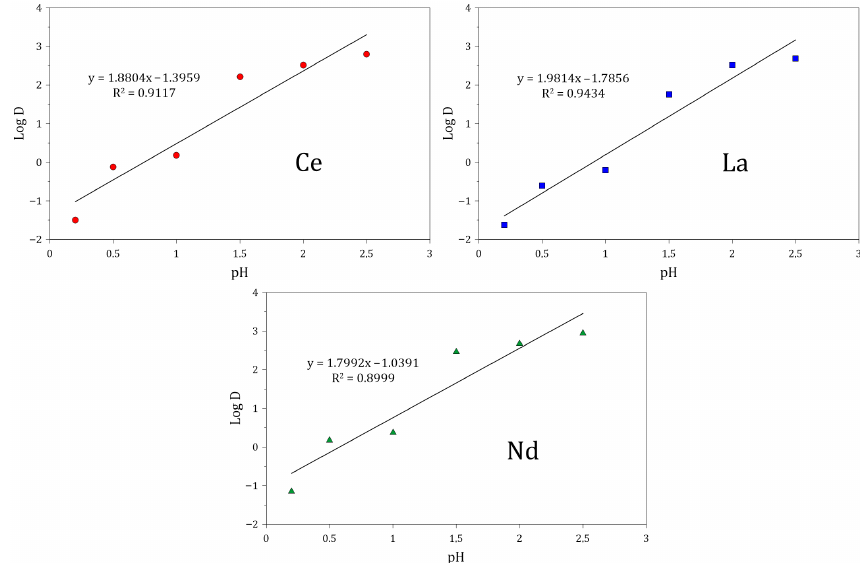
Figure 16. Log D vs. pH for the extraction of Ce , La , and Nd with D 2 EHPA .